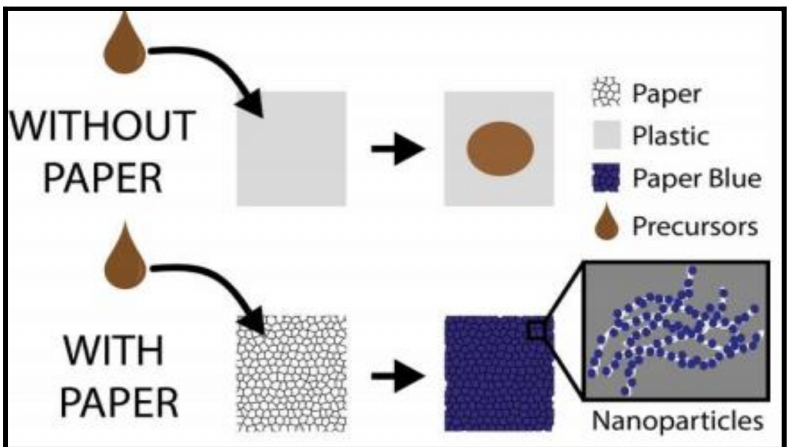
Figure 4. Favorable production of nanoparticles on paper as compared to other substrates, reproduced with permission from